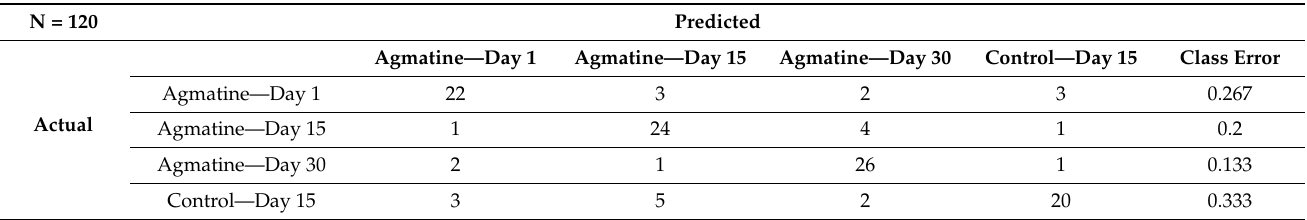
Table 13. Confusion Matrix for a Random Forest Prediction Model of Treatment and Duration. The misclassification rate (class error) is shown for the predicted treatment cohorts (columns) versus the actual treatment cohorts